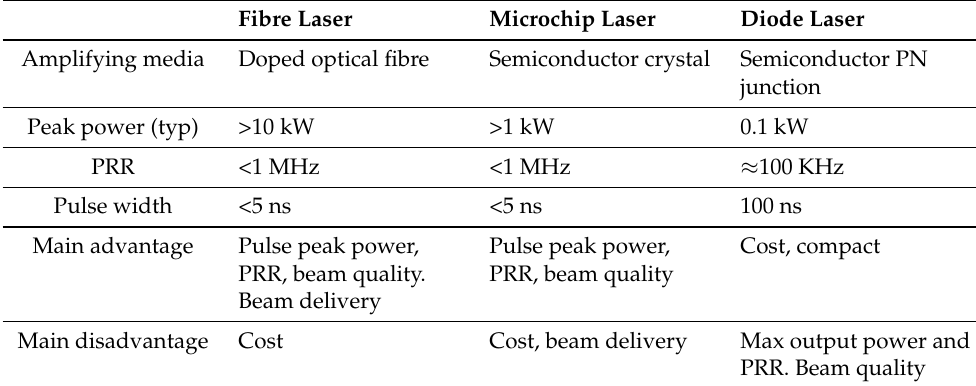
Table 3. Summary: main features of sources for